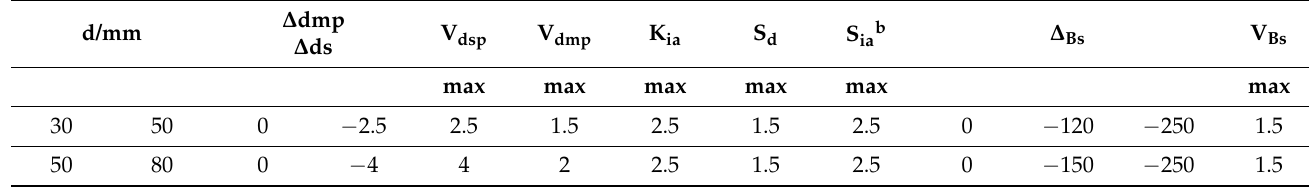
Table 3. Local P2-grade bearing tolerance.